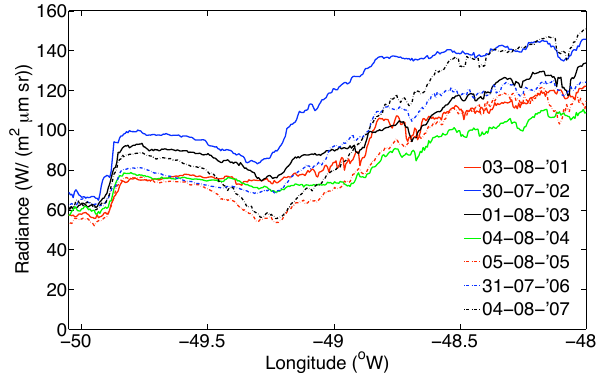
Fig. 3. Radiance profiles for different days in 2007, averaged be- tween 67.75 ◦ N to 68 ◦ N, from MODIS images.